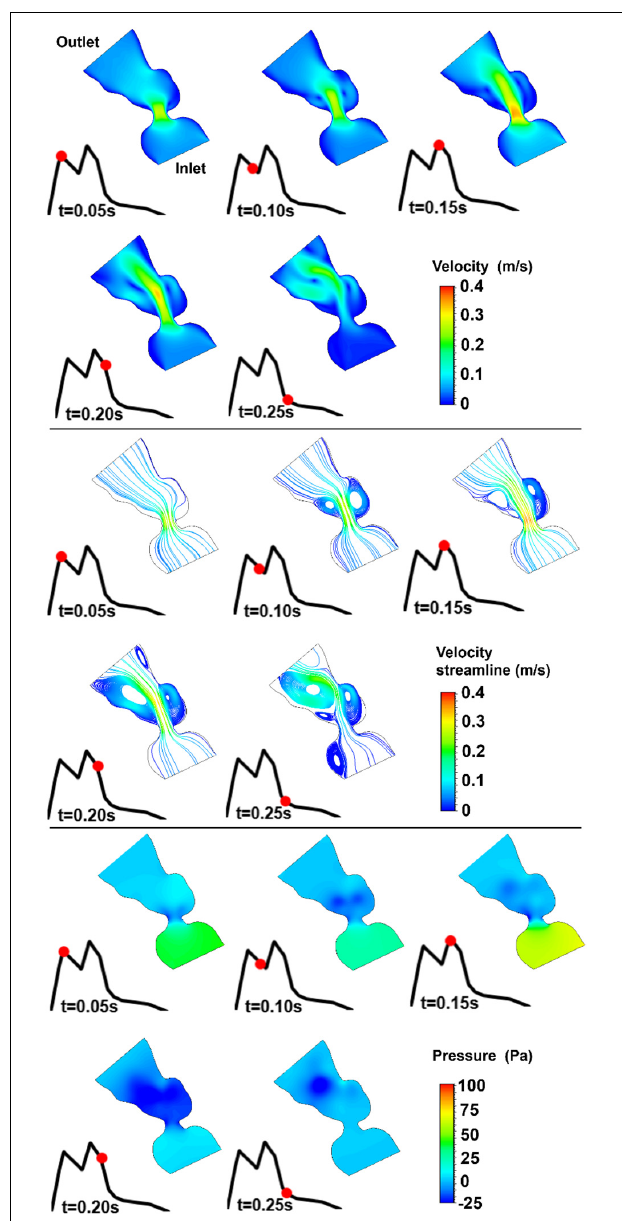
FIGURE 12 | Velocity magnitude, velocity streamline, and pressure contours for the control 5 heart at week 27. The instant in the cardiac cycle is shown near the